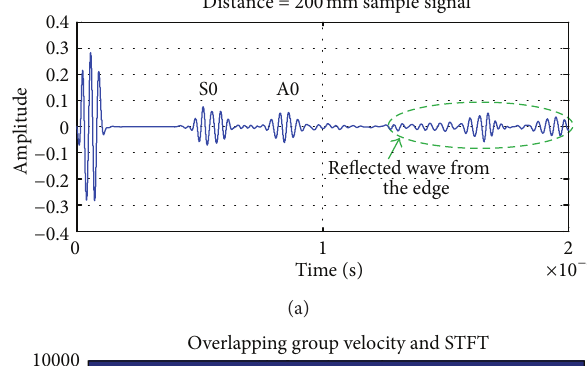
Figure 4: Received signals from various frequencies at 0.05MHz intervals.